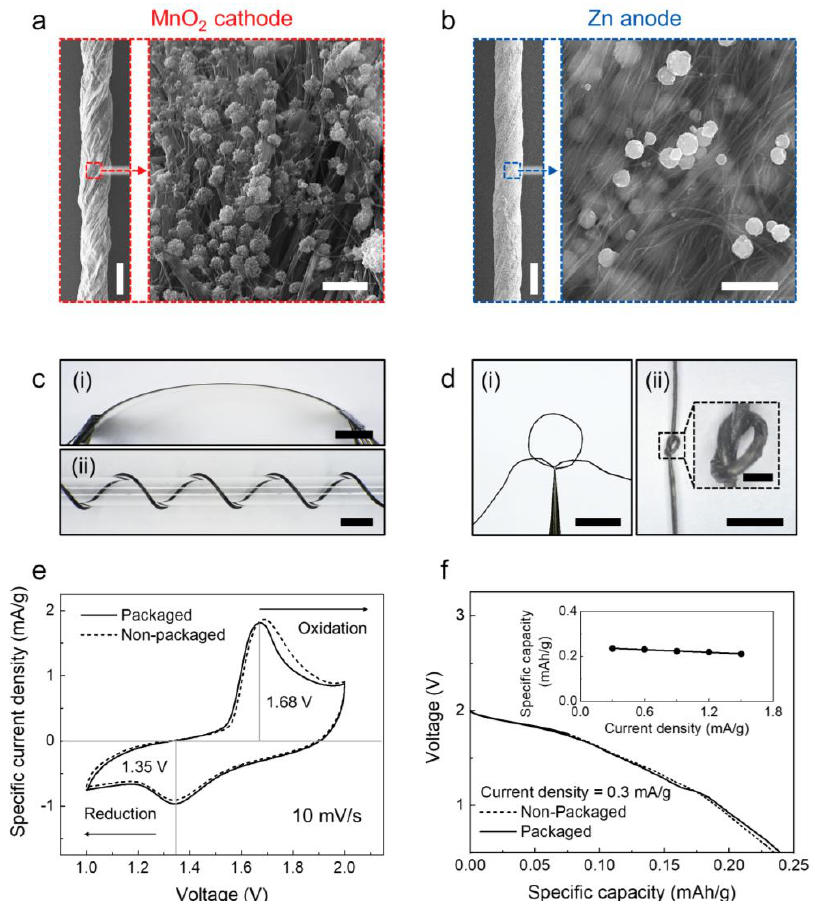
Figure 2. Scanning electron microscope (SEM) images of the ( a ) MnO 2 cathode (scale bars are 200 and 0.5 μm, respectively) and ( b ) Zn anode (scale bars are 200 and 0.5 μm, respectively) showing the entire structures and yarn surfaces of the battery electrodes. Optical images showing various mechanical deformations such as ( c ) ( i ) bending (scale bar = 5 cm) and ( ii ) winding (scale bar = 2 cm), and ( d ) ( i ) circling (scale bar = 5 cm) and ( ii ) knotting (scale bars are 2 cm and 400 μm, respectively). ( e ) Cyclic voltammetry (CV) curves of the packaged and nonpackaged MnO 2 − Zn batteries in a quasi − solid − state aqueous electrolyte measured at a scan rate of 10 mV/s. ( f ) Galvanostatic discharge curves of the nonpackaged and packaged textile batteries; the inset graph shows the dependence of the specific capacity on current density from 0.3 to 1.5